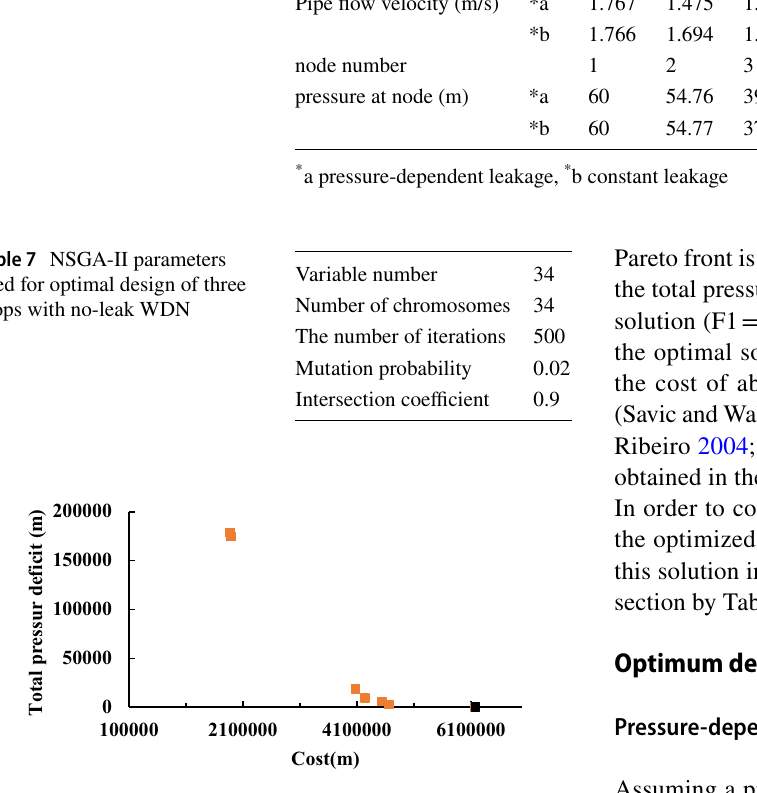
Table 6 Effect of the leakage calculation method on the geometric–hydraulic characteristics of WDN